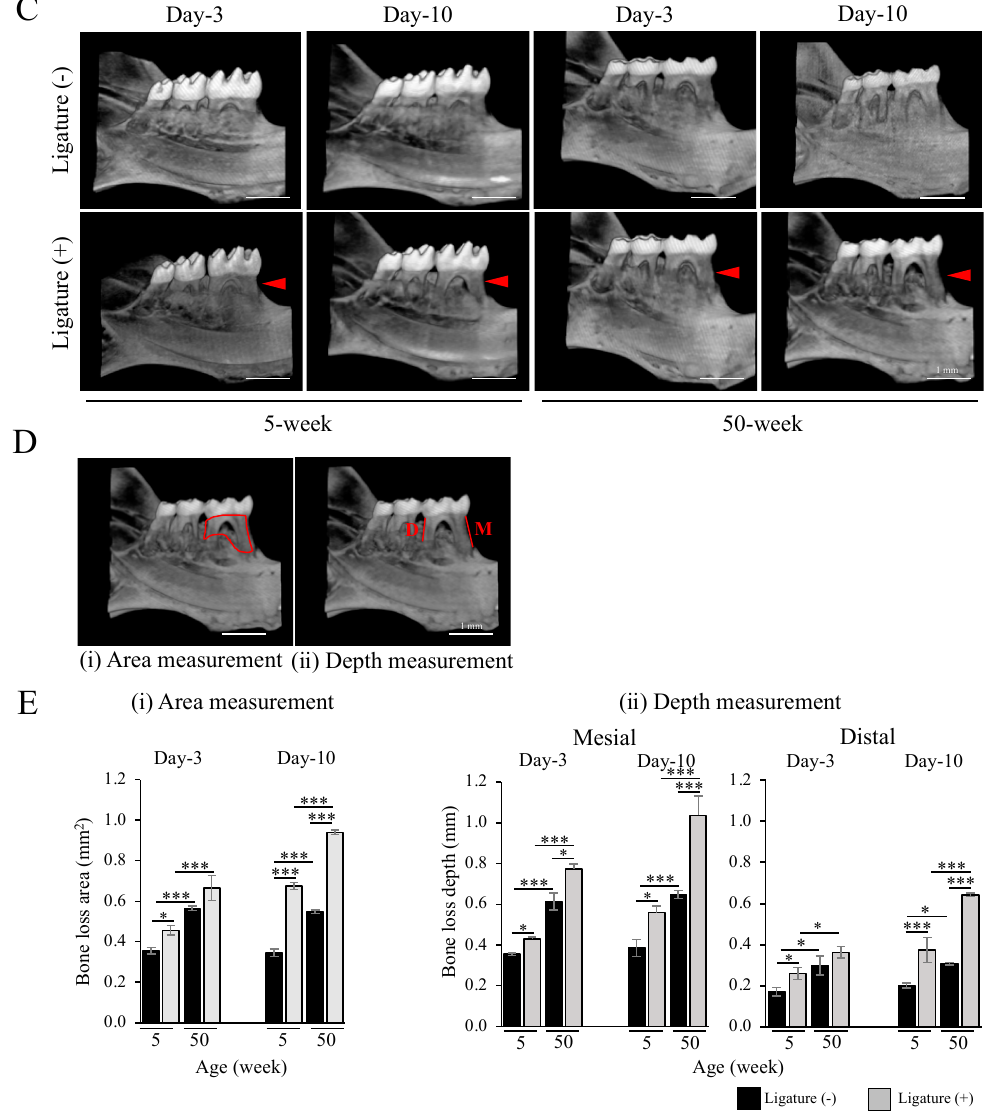
Figure 1. Periodontitis-associated bone resorption is more severe in aged mice. ( A ) Experimental design and timing of sample collection of the ligature-induced periodontitis model in mice. ( B ) Photographs of the control and periodontitis groups showing the ligature in the mandibular first molar of young (5-week-old) and aged (50-week-old) mice. Bar: 1 mm ( C ) Representative micro computerized tomography (micro-CT) images of control and periodontitis groups at day-3 and day-10 after ligation in young and aged mice (red arrow indicated bone loss). Bar: 1 mm ( D ) Bone loss measurement methods. (i) Area: measurement of the area corresponding to the exposed lingual root surfaces of the first mandibular molar as the horizontal limits, and the distances between the cemento–enamel junction (CEJ) and the resorbed alveolar bone crest as the vertical limits; (ii) depth: measurement of the linear distance from the CEJ to the alveolar bone crest on the mesiolingual and distolingual regions of the first mandibular molar, M: mesial, D: distal. Bar: 1 mm and ( E ) results of the micro-CT-based quantitative analysis of bone loss (i) area and (ii) depth, at day-3, and day-10 after ligation in young and aged mice. Note that aged mice showed more severe bone loss compared to young mice, either in the control or ligature-induced periodontitis groups. A two-way ANOVA showed a significant association between age and ligation-induced periodontitis. The bar graph represents the mean ± standard deviation of at least 3 independent samples. * p < 0.05, *** p < 0.001, two-way ANOVA, Tukey test ( n = 3).